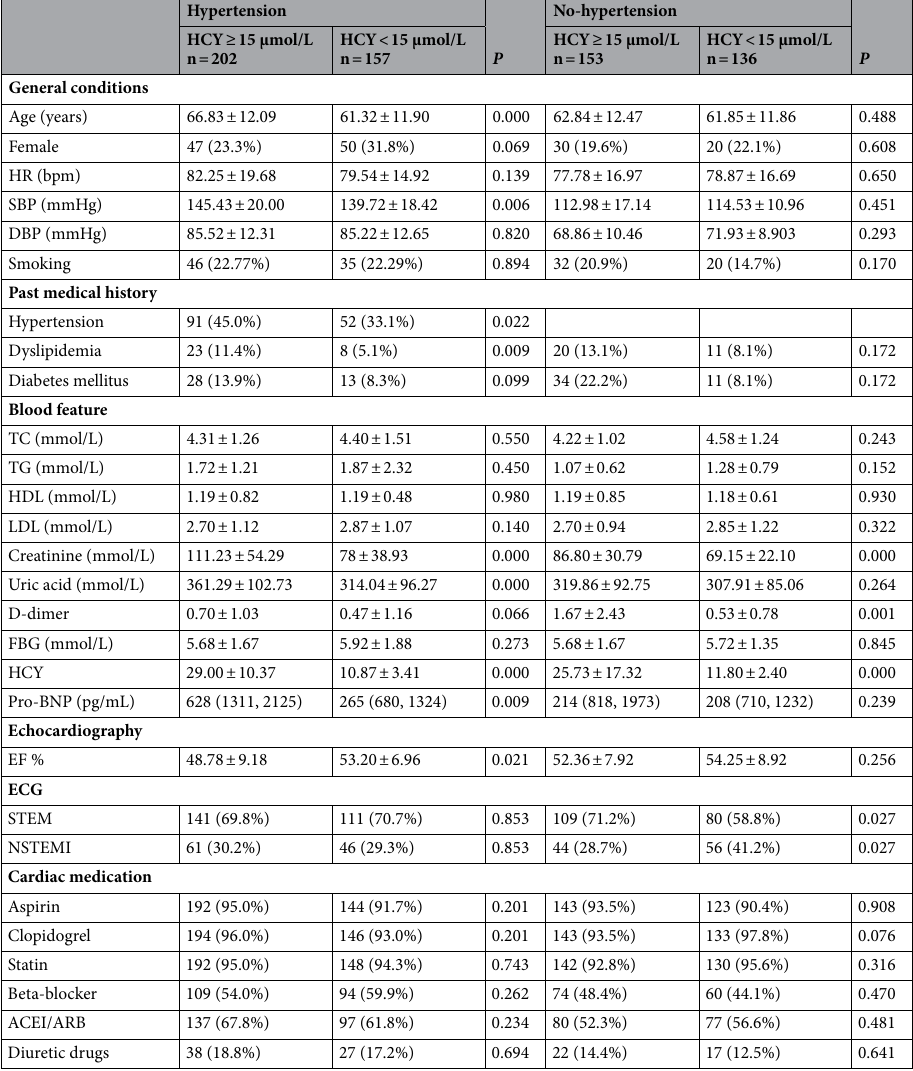
Table 1. Comparison baseline characteristics of AMI patients in different groups. Data are shown as mean ± standard deviation or n (%). Data in bold indicates P -values 0.05. HR, heart rate; SBP, Systolic blood pressure; DBP, diastolic blood pressure; CABG, coronary artery bypass grafting; PCI, percutaneous coronary intervention; HDL, high density lipoprotein; LDL, low density lipoprotein; TC, total cholesterol; TG, triglyceride; UA, uric acid; FBG, fasting blood-glucose; EF, eject fraction; ECG, electrocardiograph; STEMI, ST segment elevation myocardial infarction, NSTEMI, NON-ST segment elevation myocardial infarction, ACEI, angiotensin converting enzyme inhibitor; ARB, angiotensin receptor